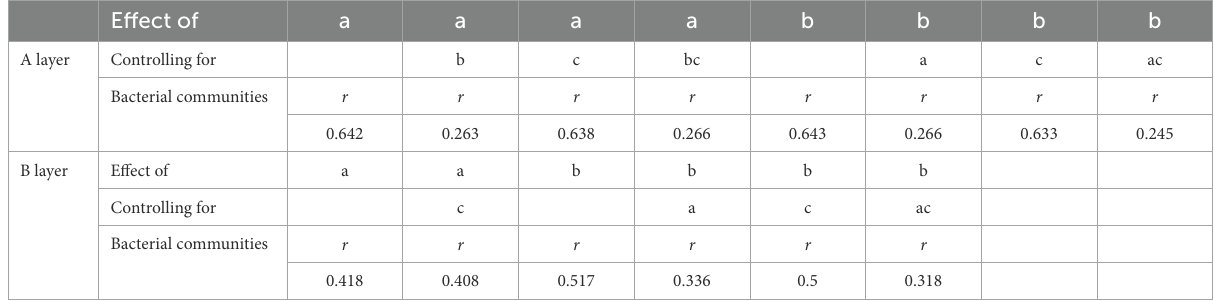
TABLE 2 Influence of altitudinal gradients and soil physical/chemical properties on soil bacterial communities by partial Mantel test with soil depth changes in karst graben basin of Yunnan-Kweichow Plateau. Effect